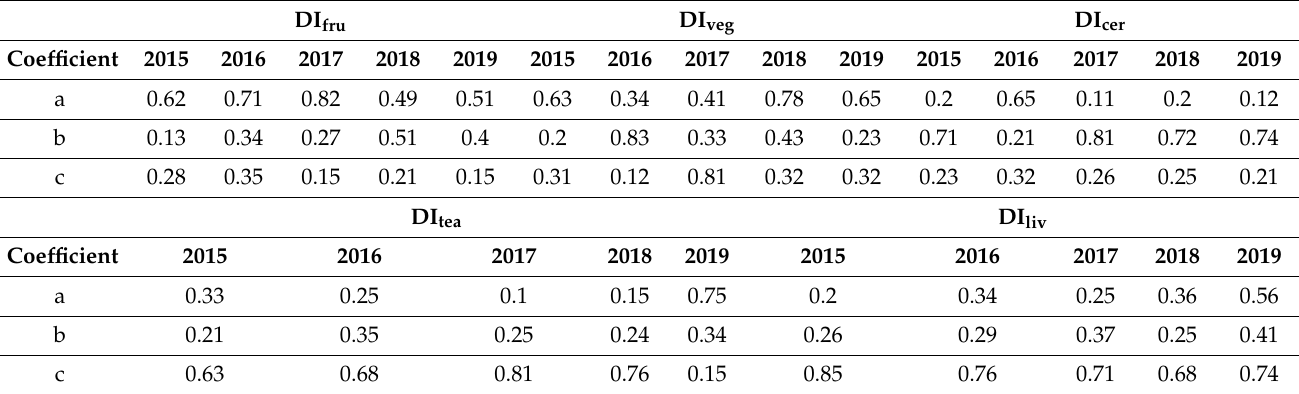
Table 1. Component score coefficient matrix of factor analysis. DI fru DI veg DI